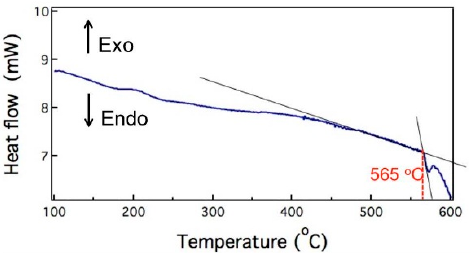
Figure 2. Differential scanning calorimeter (DSC) data of 6066 aluminum alloy. Exo: exothermic; Endo: endothermic.